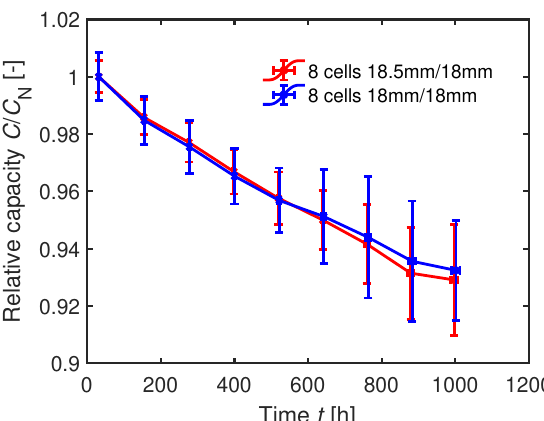
Figure 14. Averaged relative capacities of the two cell groups during cyclic aging with 1C. For each group, the eight best cells have been